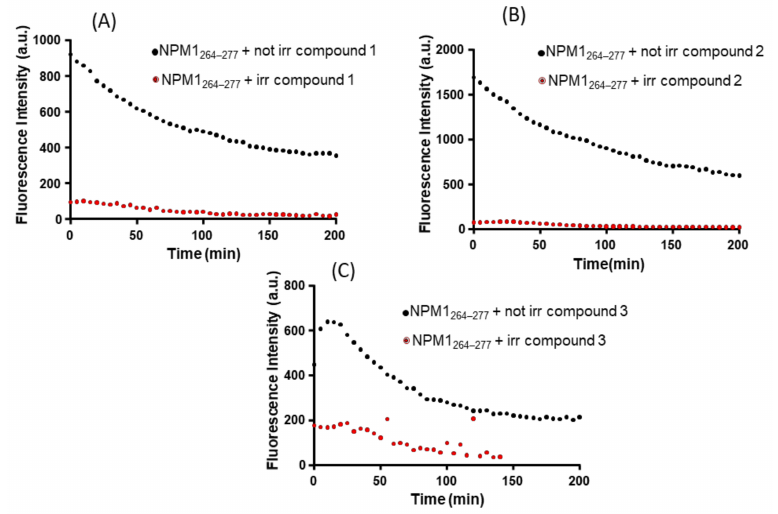
Figure 3. Overlay of time-courses of ThT fluorescence emission intensity of NPM1 264–277 in presence of the three Ru(II) complexes: ( A ) compound 1 ; ( B ) compound 2 (C) compound 3 , at 1:1 peptide to metal-based compound molar ratio. Results are representative of two independent